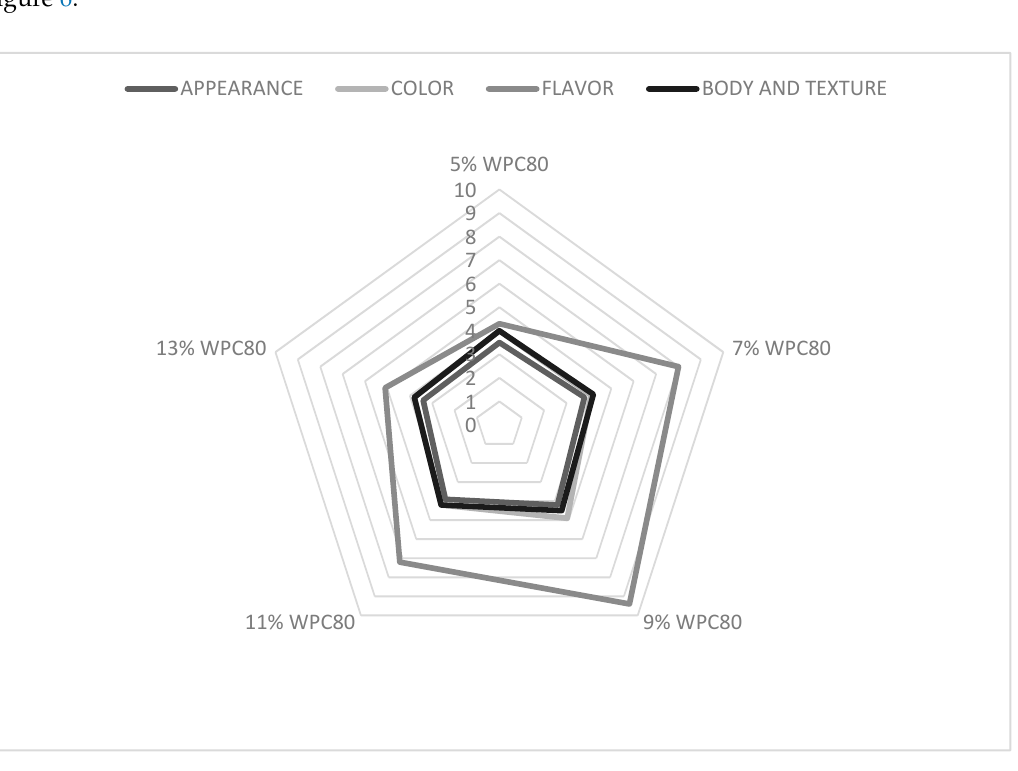
Figure 6. Effect of different WPC80 contents on the organoleptic features of high-protein fat-free dairy desserts. Points from 1 to 10 describe the acceptability of the products (Flavor: 1—the lowest score, 10—the highest score; Body, texture, appearance and color: 1—the lowest score, 5—the highest score).